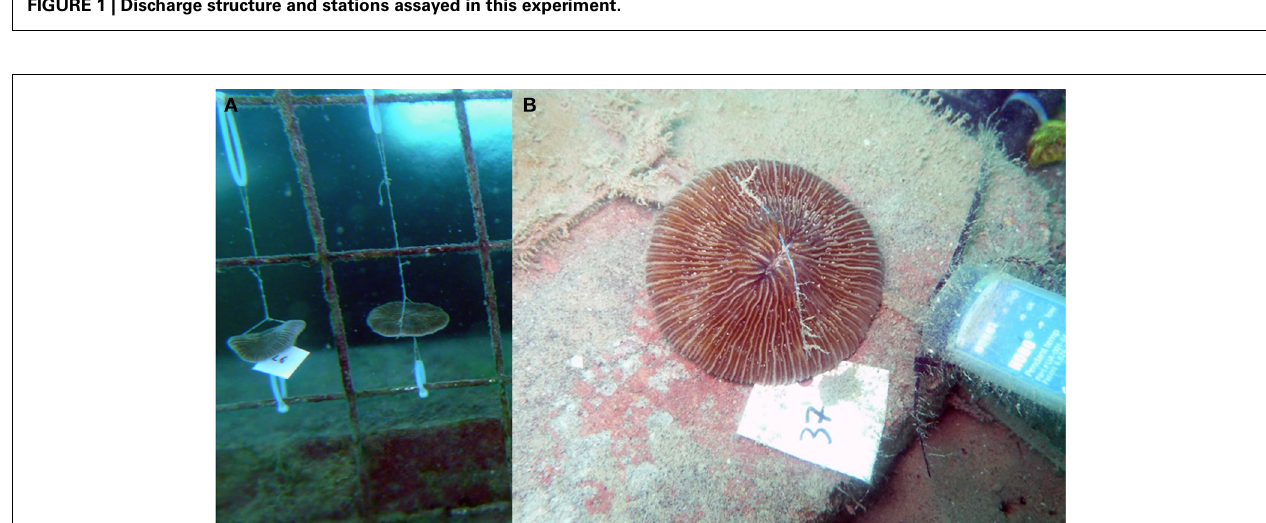
FIGURE 1 | Discharge structure and stations assayed in this experiment.